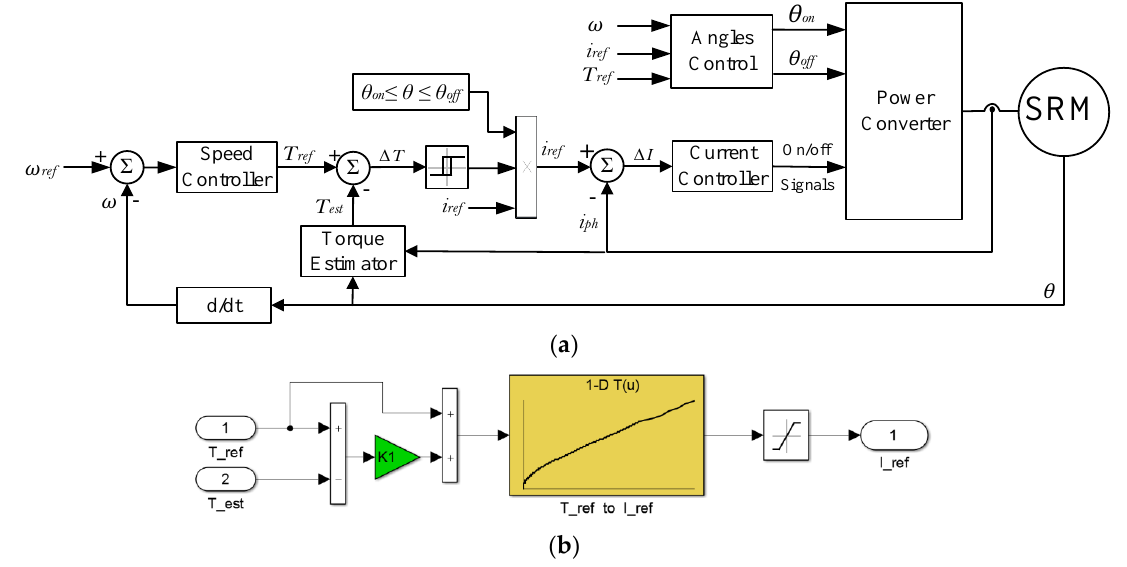
Figure 5. The universal torque control (UTC) of SRM.